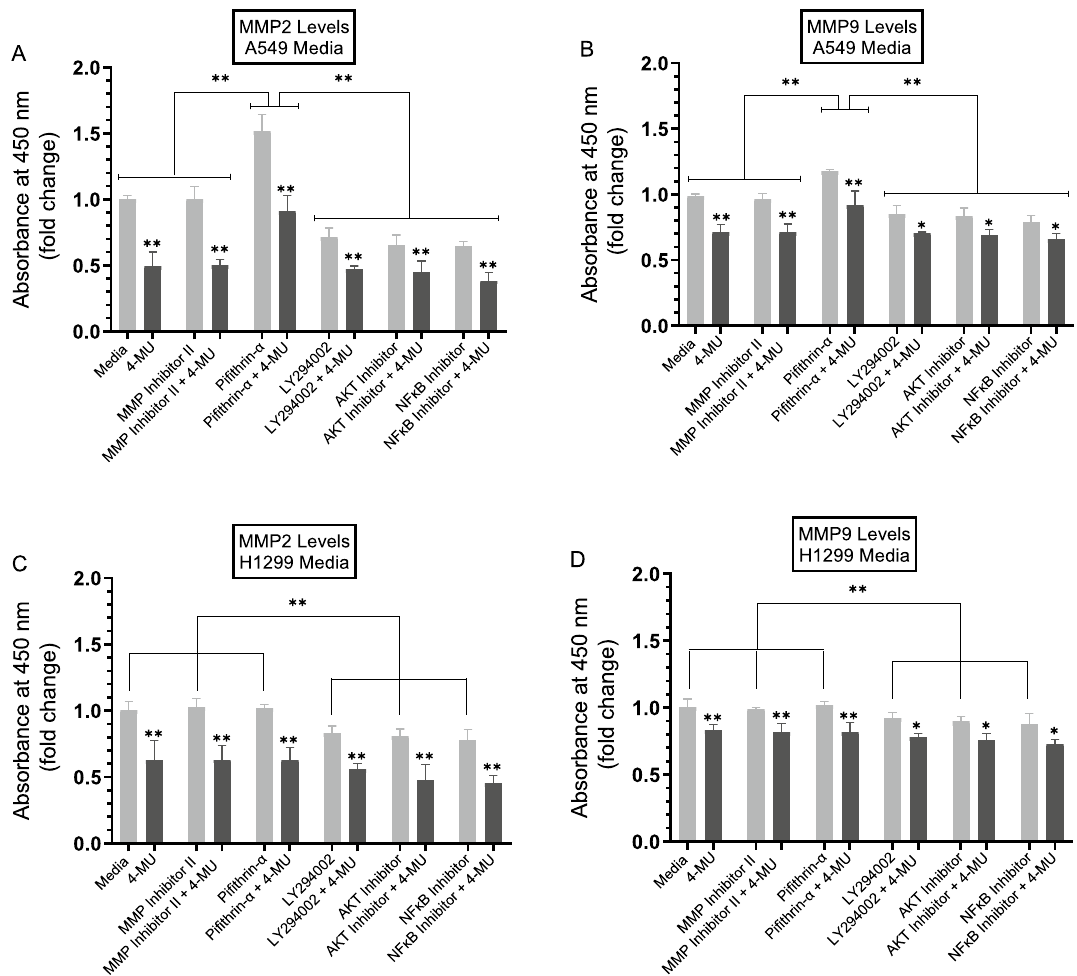
Figure 4. Higher levels of MMP2 than MMP9 were detected in the conditioned media of A549 cells upon treatment with the p53 inhibitor, pifithrin-α. Cells (0.2 × 10 5 ) were grown in 10% FBS-supplemented media for 24 h. The following day, the cell monolayers were incubated in serum-free media for 24 h, then treated as indicated for 72 h with the inhibitors without and with 600 µM 4-MU as described in the “Methods” section. The media was collected then the same amount of protein (3 µL of 600 µg/mL total protein) of each sample was used to quantitate MMPs (“Methods” section). Data from five independent assays, each carried out in triplicate, were quantitated, averaged, normalized, and expressed as fold change relative to cells not treated with 4-MU using the GraphPad 8.4.3 software. The graphs summarize the results expressed as means ± SD (n = 5). Asterisks (*) indicate a statistically significant difference from the corresponding samples without 4-MU treatment for each cell line, Mann–Whitney test. Statistical differences between different groups were analyzed by an ordinary one-way analysis of variance (ANOVA) followed by Tukey’s post-hoc multiple comparison test. * p < 0.05, ** p <